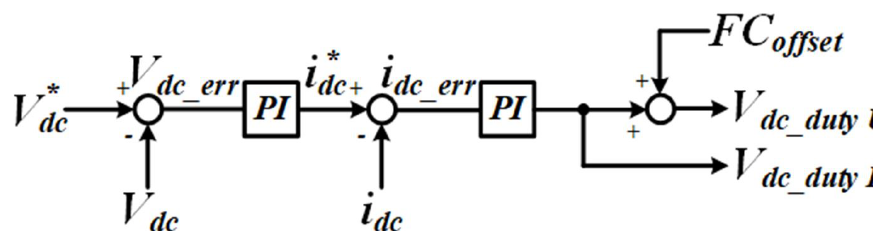
Figure 6. Control block diagram of buck converter.